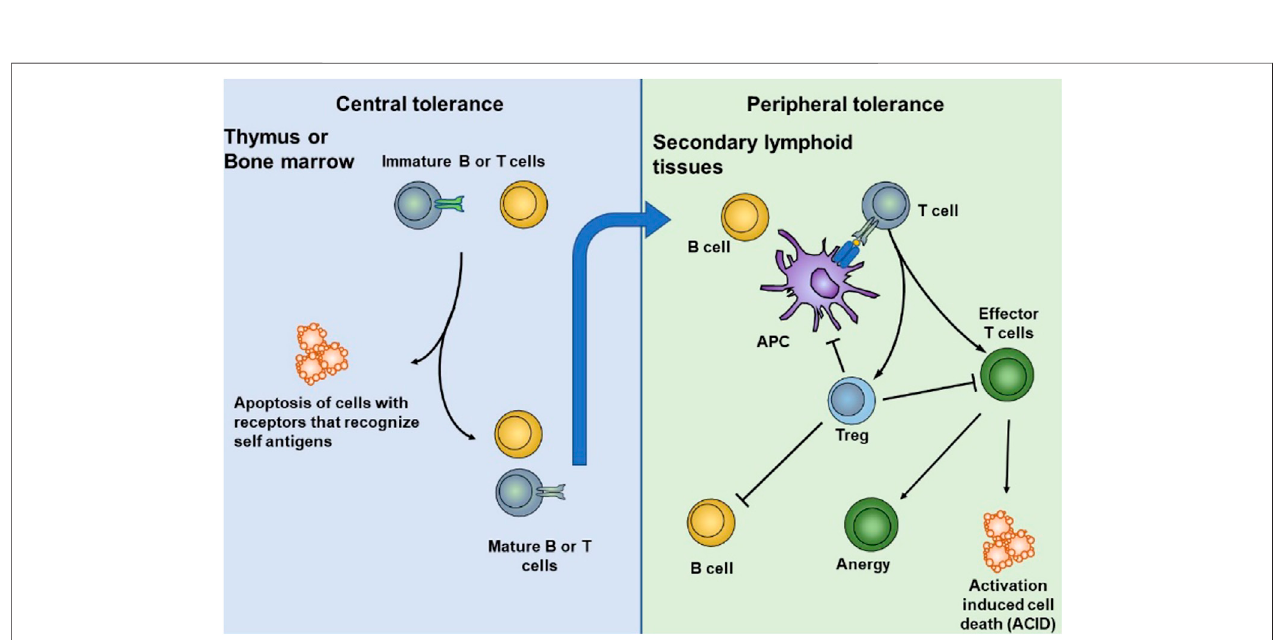
FIGURE 2 | DCs play an essential role in central and peripheral immune tolerance. In central tolerance, most of the autoreactive T and B lymphocytes are cleared during the early stages of thymus and bone marrow development. Some self-reactive lymphocytes that escape central tolerance are cleared, anergized, deleted, or differentiated into normal T cells in peripheral tolerance. Reproduced with permission from (Yu et al.,